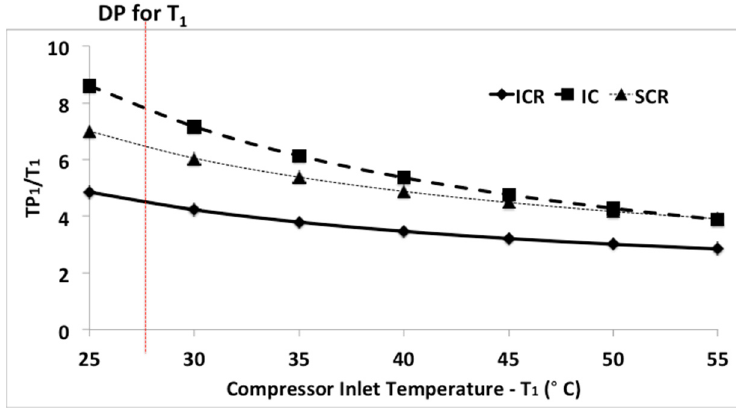
Figure 6. Hot Gas Helium at Precooler Inlet. Hot gas helium is normalised by the respective cycle/compressor inlet temperatures.